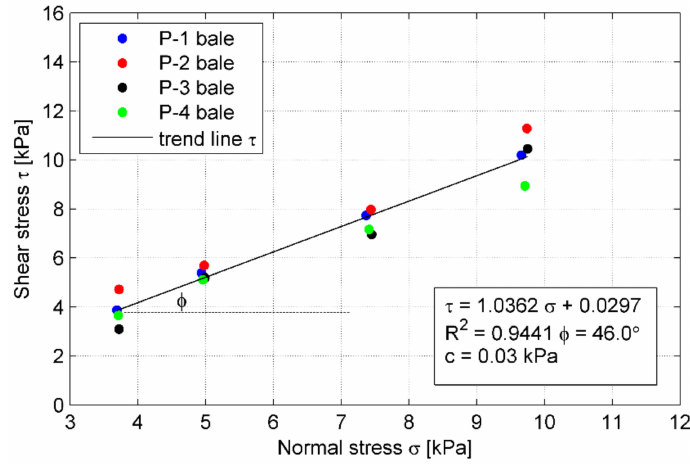
Figure 19. Shear strength envelope for tyre–tyre